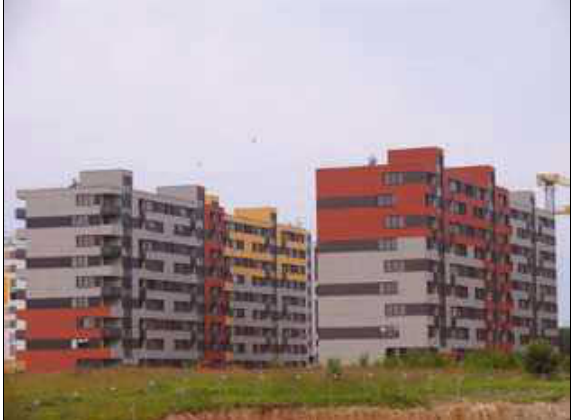
22 pav. Dau­giabu­čių gyvenamųjų namų kvartalas Fabijoniškėse, Ukmergės g. (archit. L. Grikinienė) Fig. 22. blocks of flats in Fabijoniškės, Ukmergė st. a­rch. L.